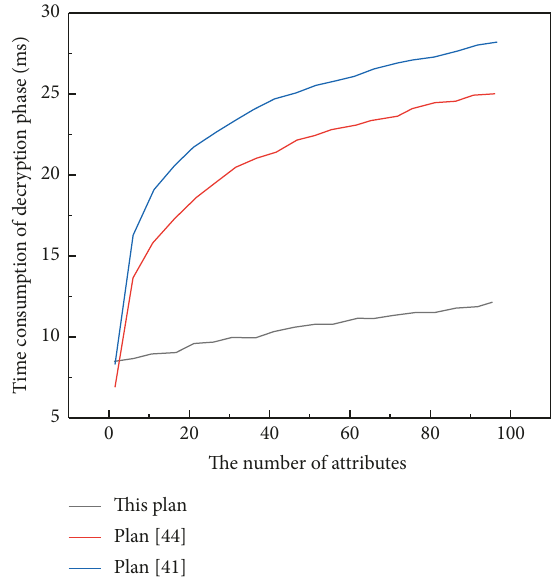
Figure 6: Time consumption of decryption